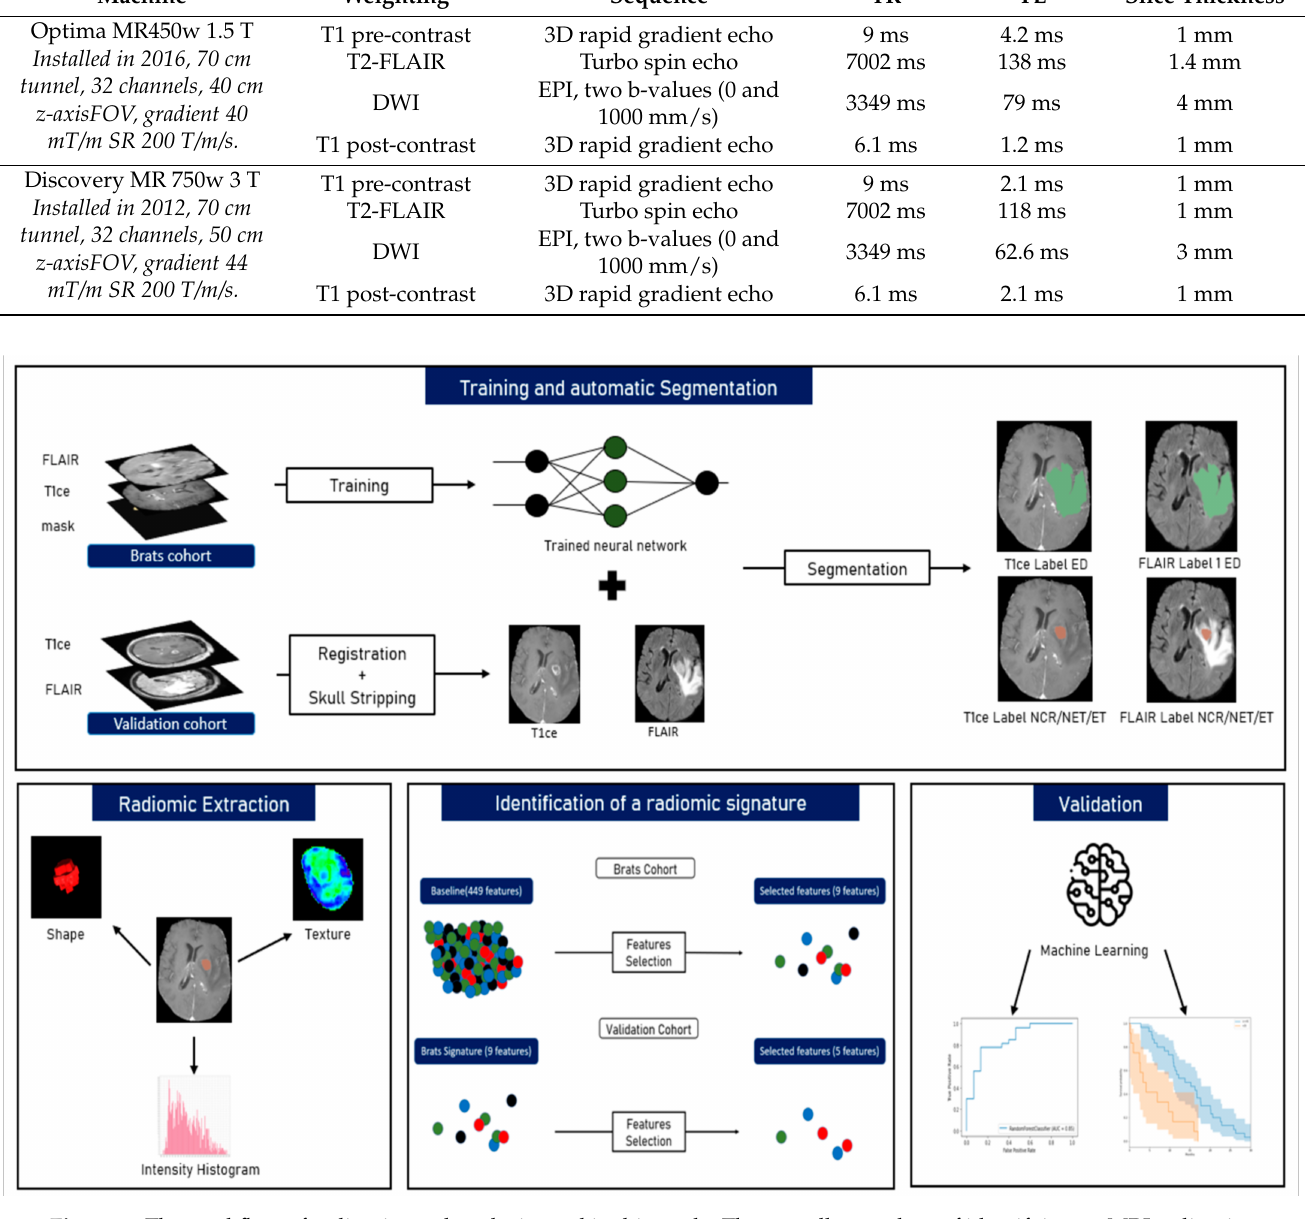
Figure 1. The workflow of radiomics and analysis used in this study. The overall procedure of identifying an MRI radiomics signature model and a practical ML model for the stratification of the GBM patients’ prognosis based on